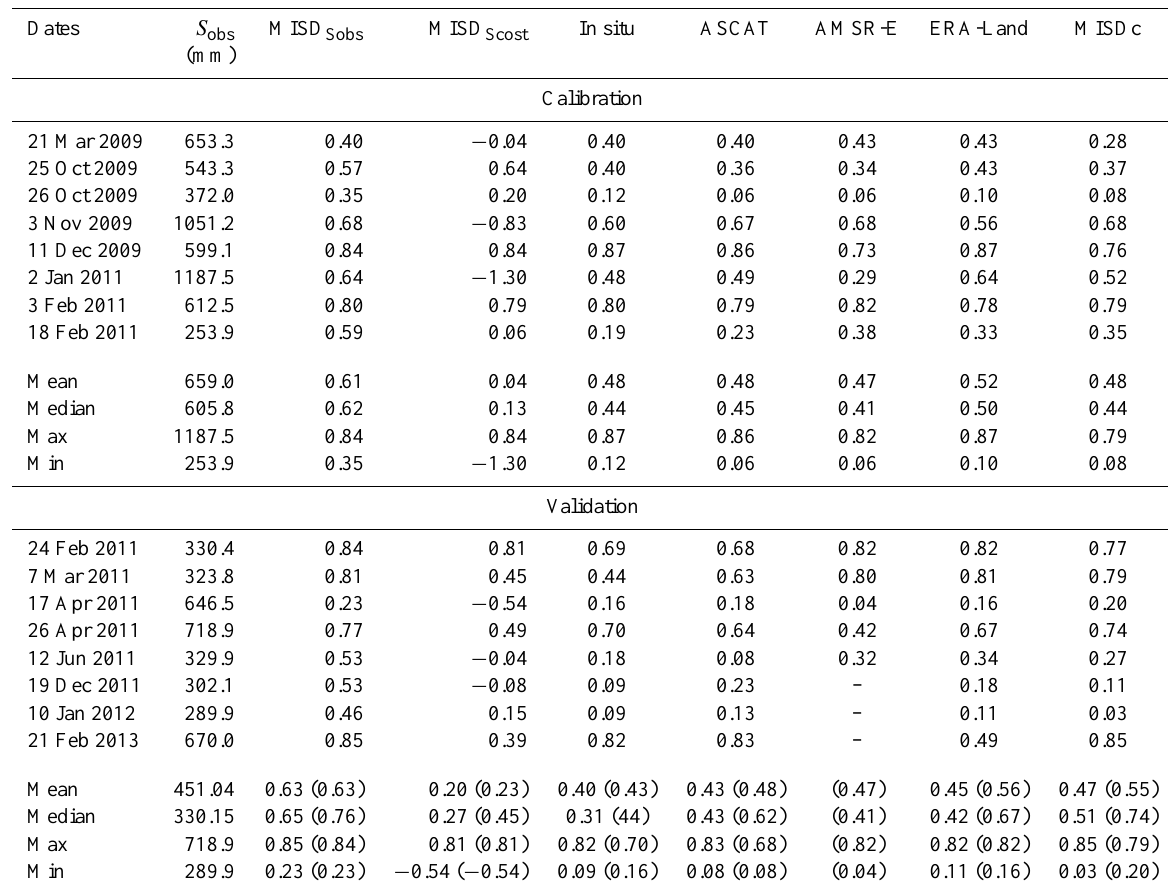
Table 4. Performance of the models used in the study in terms of Nash–Sutcliffe coefficient NS. S obs refers to “observed” soil poten- tial maximum retention determined by using observed rainfall and direct runoff depth; MISD Sobs =NS obtained from MISD using S obs ; MISD Scost =NS obtained from MISD using constant observed initial conditions (equal to the mean of S obs among all the selected events); in situ=NS obtained from SCRRM using S estimated from in situ SM measurements; ASCAT=NS obtained from SCRRM using S esti- mated from ASCAT SM measurements; ERA-LAND=NS obtained from SCRRM using S estimated from ERA-Land SM measurements; AMSR-E=NS obtained from SCRRM using S estimated from AMSR-E SM measurements; MISDc=NS obtained from MISDc. Numbers in brackets in the validation period refer to the statistics calculated for the flood events for the period 24 February 2011 to 12 June 2011 (the only available for